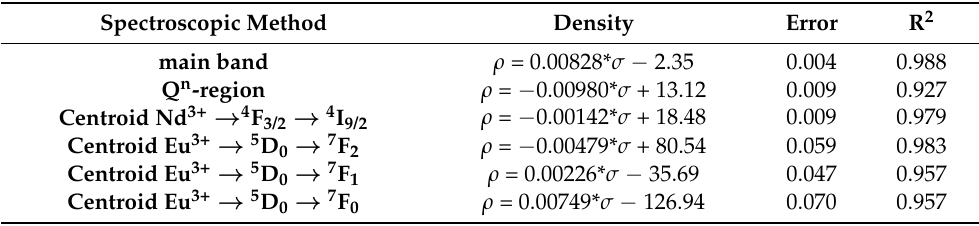
Figure 12. ( A ) Comparison of the different evaluated transitions of the luminescence of Nd 3+ ( 4 F 3/2 → 4 I 9/2 ≙ green squares/dashed) and Eu 3+ (pink hexagons/short dashed ≙ 5 D 0 → 7 F 2 ; lavender circles/dotted ≙ 5 D 0 → 7 F 1 , purple triangles/dashed-dotted ≙ 5 D 0 → 7 F 0 ) versus applied P max . ( B ) Comparison of the different evaluated transitions of the luminescence of Nd 3+ and Eu 3+ with changing density; all transitions show a linear behavior and a rather large shift; the largest magnitude of shift is obtained for the hypersensitive transition of the Nd 3+ with a fitted variation Δ = − 66.31 ± 0.65%, REE-luminescence is considered as a high-potential intrinsic density sensor in glass. Table 2. Linear fitting equations for the various spectroscopic methods to calculate density as function of the centroid σ ; the error was estimated as the mathematical mean of the difference ( ρ measured − calibration ) of the cylinders densified at various P max .